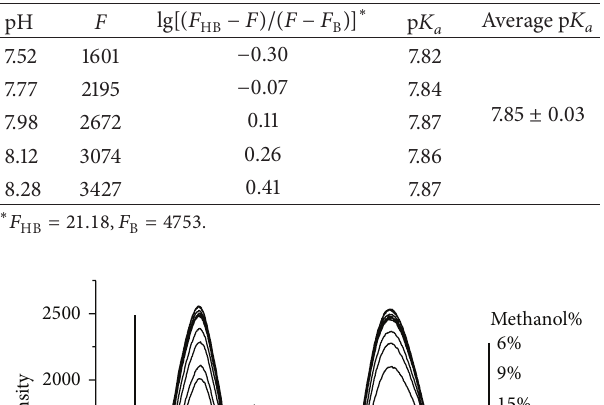
Table 1: Determination of ionization constant of 4MU.